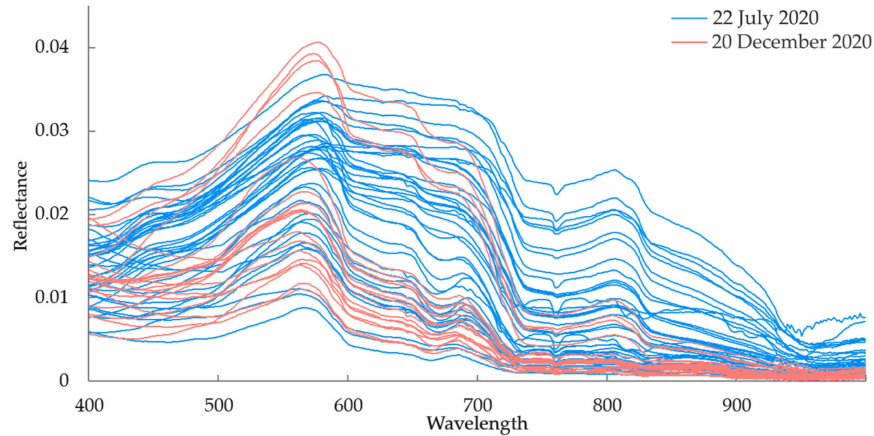
Figure 7. Field-measured spectral series of R rs collected on 22 July and 20 December 2020.